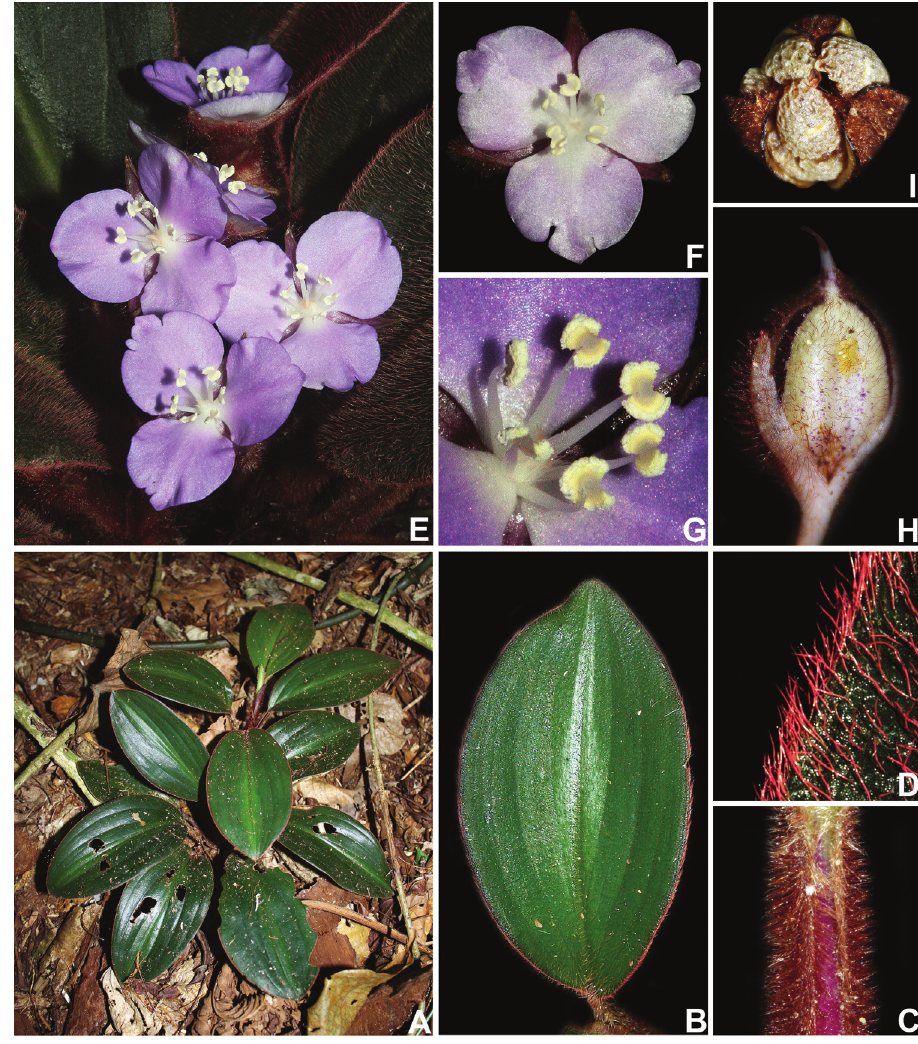
Figure 8. Siderasis fuscata (Lodd.) H.E.Moore. A habit, showing a mature rosette and green leaves B detail of leaf with a silvery blotch along the midvein C detail of the canaliculate petiole, showing the rusty hairs D detail of the bright-red hirsute indumentum E upper view of a fertile rosette, showing many lilac flowers open at the same time F front view of a pale-lilac flower, showing the lacerated petals and completely white androecium and gynoecium G detail of the androecium and the gynoecium H detail of a mature capsule, showing the atro-vinaceous longitudinal stripes I detail of an open capsule, showing the biseriate to partially uniseriate, inconspicuously arillate seeds, with grey foveolate testa. Photographs by M.O.O.